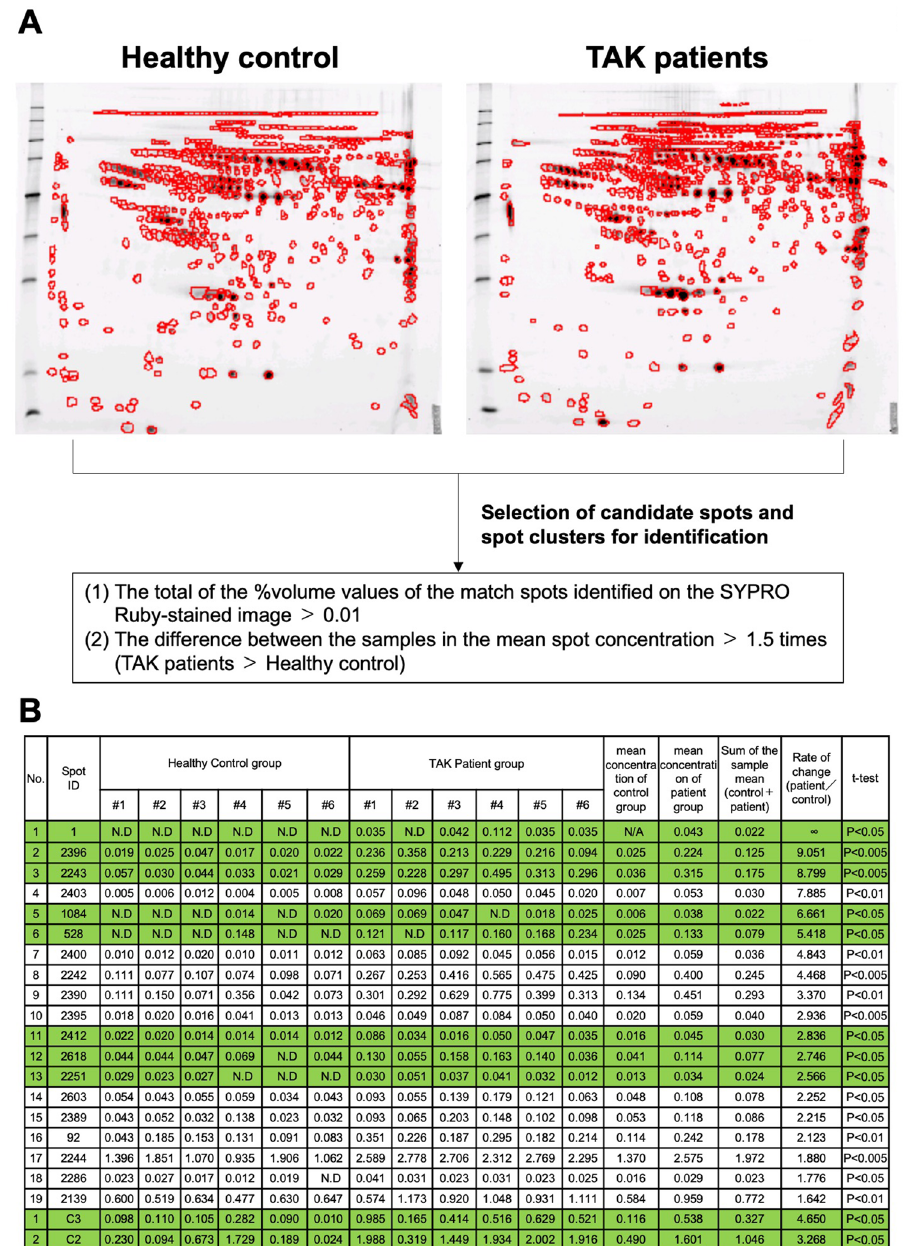
Figure 2. ( A ) Representative gel images visualized using a fluorescent scanner and protein spots detected using Image Master 2D Platinum software. Left: healthy control group. Right: Takayasu arteritis (TAK) patient group. ( B ) Numerical analysis of the obtained fluorescently stained spots after two-dimensional electrophoresis and digitization. There are 19 spots and 3 spot clusters whose sum of the sample means is 0.01 or greater and the mean spot concentration is 1.5 times or higher ( P < 0.05) in the TAK patient group compared with the control group. Among them, 10 spots and spot clusters that meet the condition of mean spot concentration of 2.5 times or higher ( P < 0.05) in the TAK patient group compared with the control group are selected (ID: 1, 2396, 2243, 1084, 528, 2412, 2618, 2251, C3, and C2, highlighted in